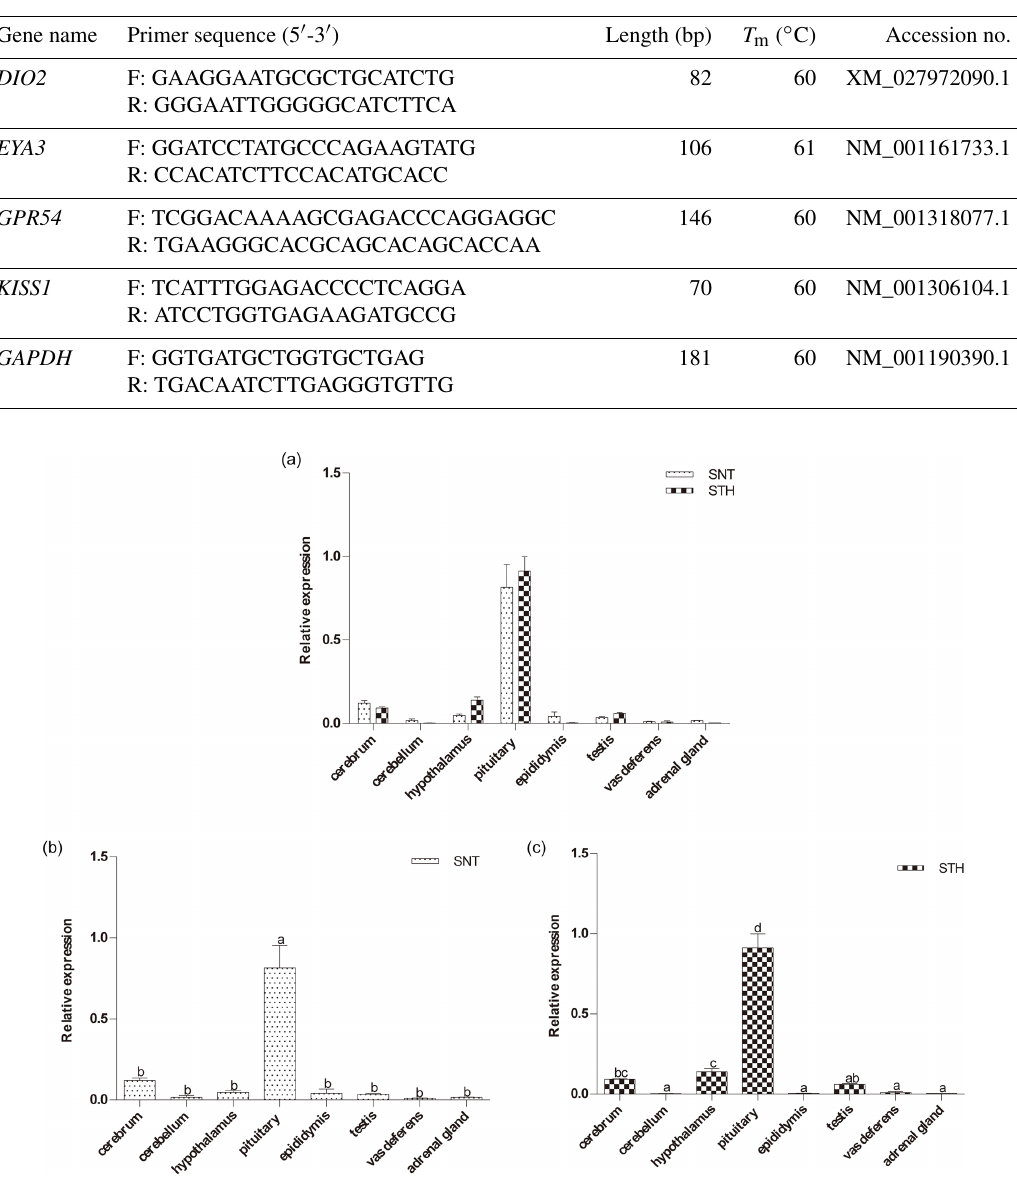
Figure 1. The expression of DIO2 in eight tissues of small-tail Han sheep (STH) and Sunite sheep (SNT): (a) the comparison of the expres- sion between SNT and STH, (b) the expression in SNT and (c) the expression in STH. Means with different superscripts are significantly different ( P < 0 . 05). The significant results with a p value lower than 0.05 are given one asterisk ( ∗ ) and lower than 0.01 are given two asterisks ( ∗∗ ),